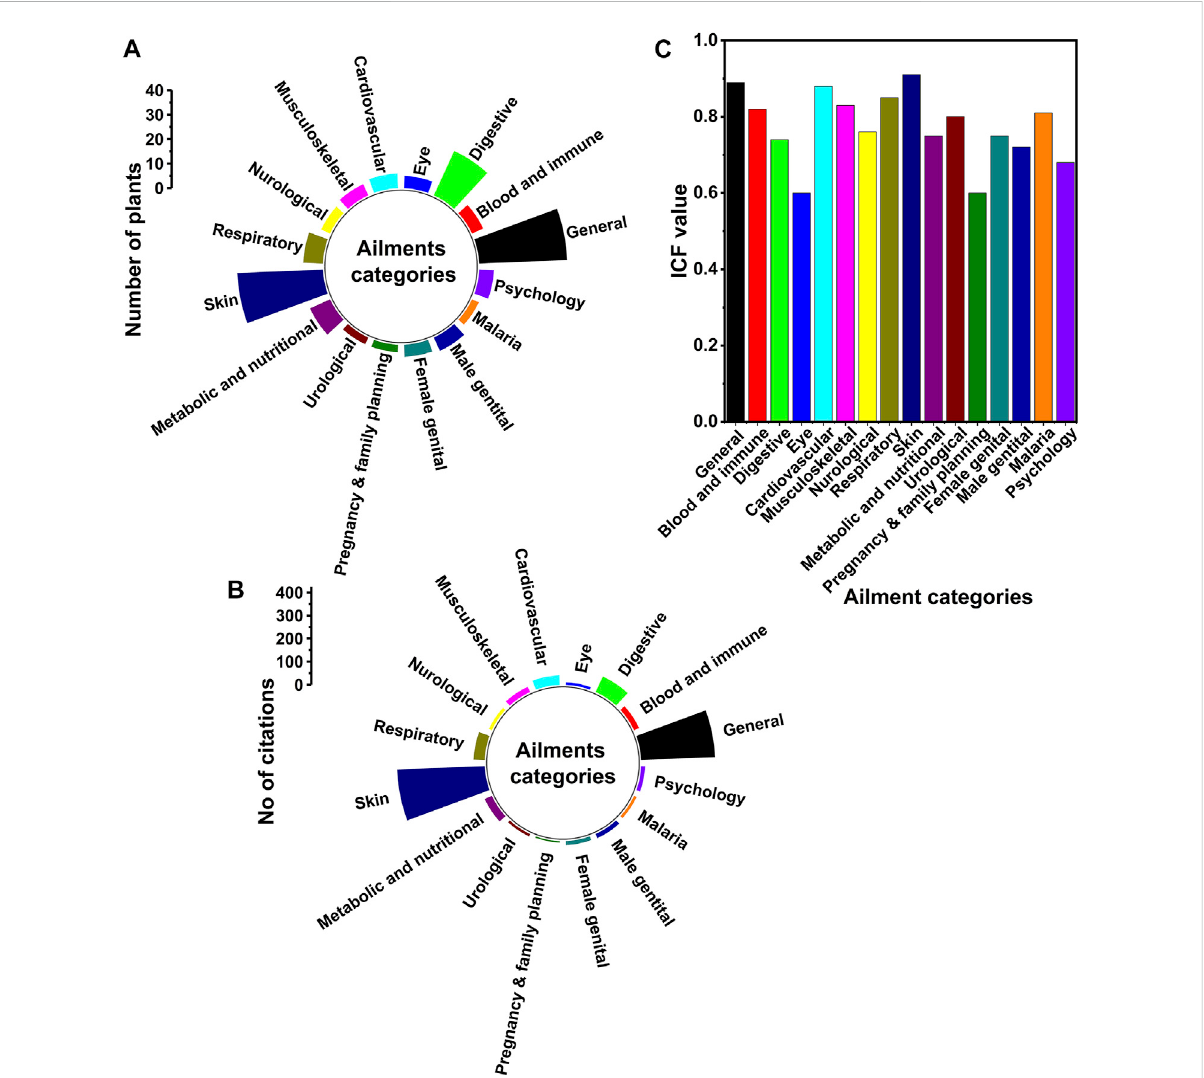
FIGURE 7 Ailmentstreatedbythetraditionalhealers.The fi gure depictstheailmentstreatedbythetraditionalhealersaroundGullelebotanicalgarden. (A) Ailment categoriesalong with thenumber ofmedicinalplantscited for each ailment (B) Ailment categoriesalong with thenumber of citations made by the healers against each ailment (C) Informant consensus factor value for each ailment category. The ailments have been categorised as per the International Classi fi cation of Primary Care